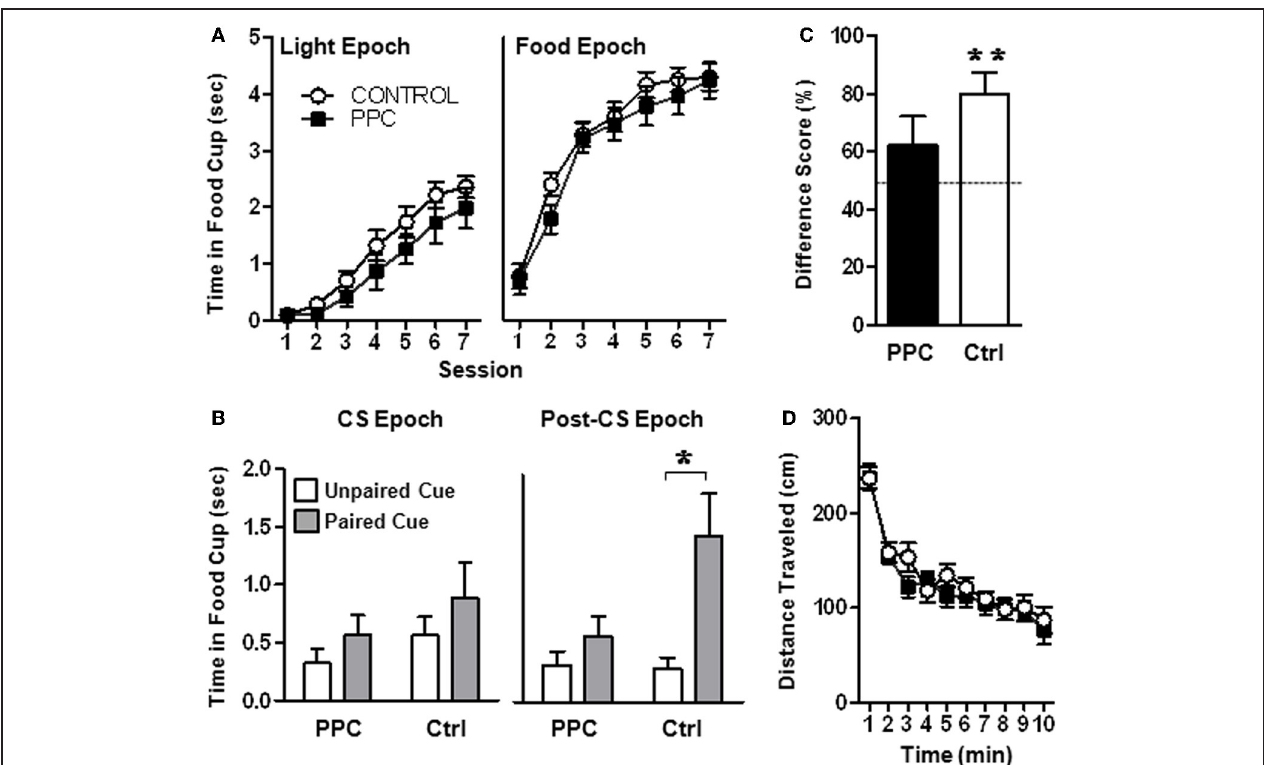
FIGURE 3 | Experiment 1. PPC-lesioned rats exhibit impaired sensory preconditioning. (A) Food cup responding during the Light epoch (left panel) and during the Food epoch (right panel) during Phase 2 of the sensory preconditioning task. No group differences were observed, indicating that PPC damage did not affect light-food conditioning or food retrieval. (B) Food cup responding during the CS epoch (left panel) and the Post-CS epoch (right panel) following presentation of the two auditory stimuli during the post-conditioning phase. Control but not PPC-lesioned rats exhibited sensory preconditioning, evidenced by greater food cup responding during presentation of the auditory stimulus that was previously paired with the light compared to the unpaired auditory stimulus during the Post-CS epoch.